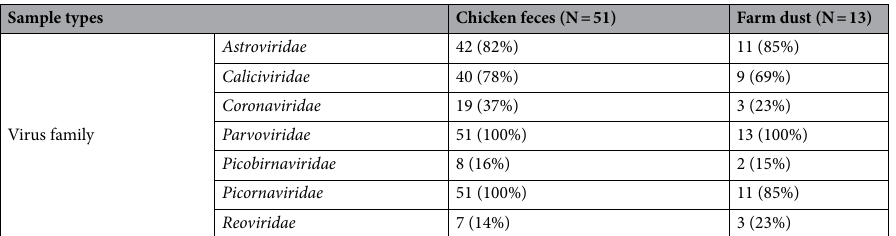
Table 1. Detection of viral sequences from different eukaryotic virus families in chicken feces and farm dust samples. N is the total number of the samples. The value represents the number of viral sequences with minimum amino acid identity of 70%, minimum length of 300 nt and an e-value threshold of 1 × 10 –10 were included. The percentage is the detection percentage of the virus family in our